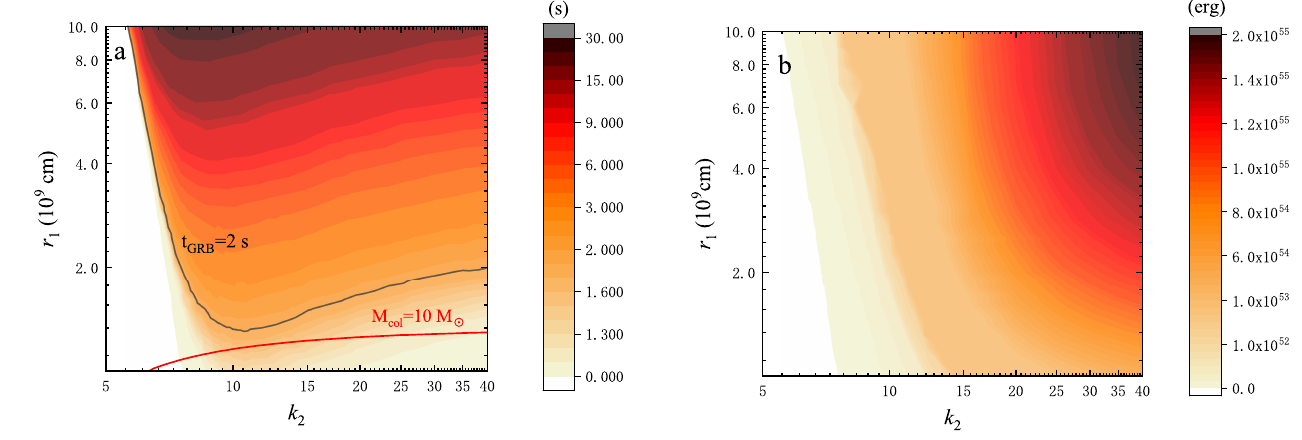
Figure 2. Panel ( a ): GRB duration t GRB as function of r 1 and k 2 for the neutrino-driven jet model. Black line corresponds to t GRB = 2 s. Red line corresponds to collapsar mass M col = 10 M (cid:12) . Panel ( b ): isotropic energy E γ ,iso as function of r 1 and k 2 . (adapted with permission from Ref.